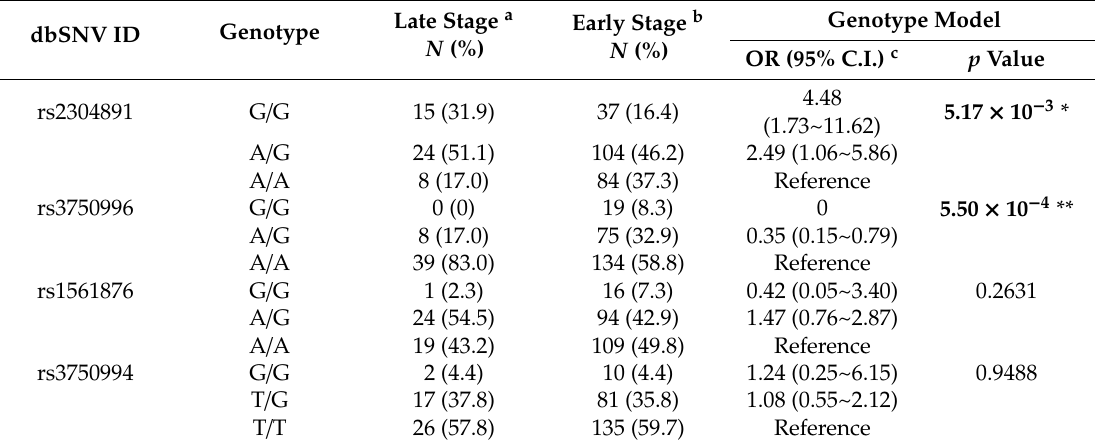
Table 3. Association analysis between germline genetic polymorphisms of STIM1 and TNM stage in breast cancer